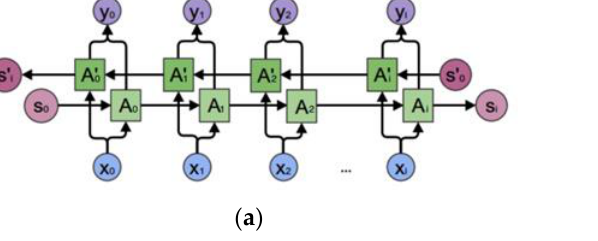
Figure 4. BLSTM network construction. ( a ) Schematic diagram of BLSTM network construction. ( b ) Construction diagram of Memory cell A in the BLSTM.